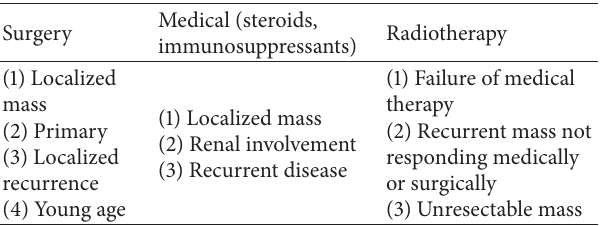
Table 2: Kimura’s disease management options along with indica- tions [2]. (1) Once diagnosed rule out renal involvement first. (2) Choose one of the following treatment options according to pre- sented indications as